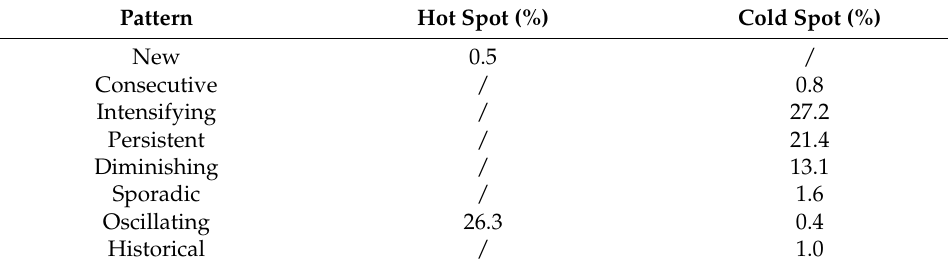
Table 3. Proportions of cold and hot spot patterns globally for confirmed COVID-19 cases.